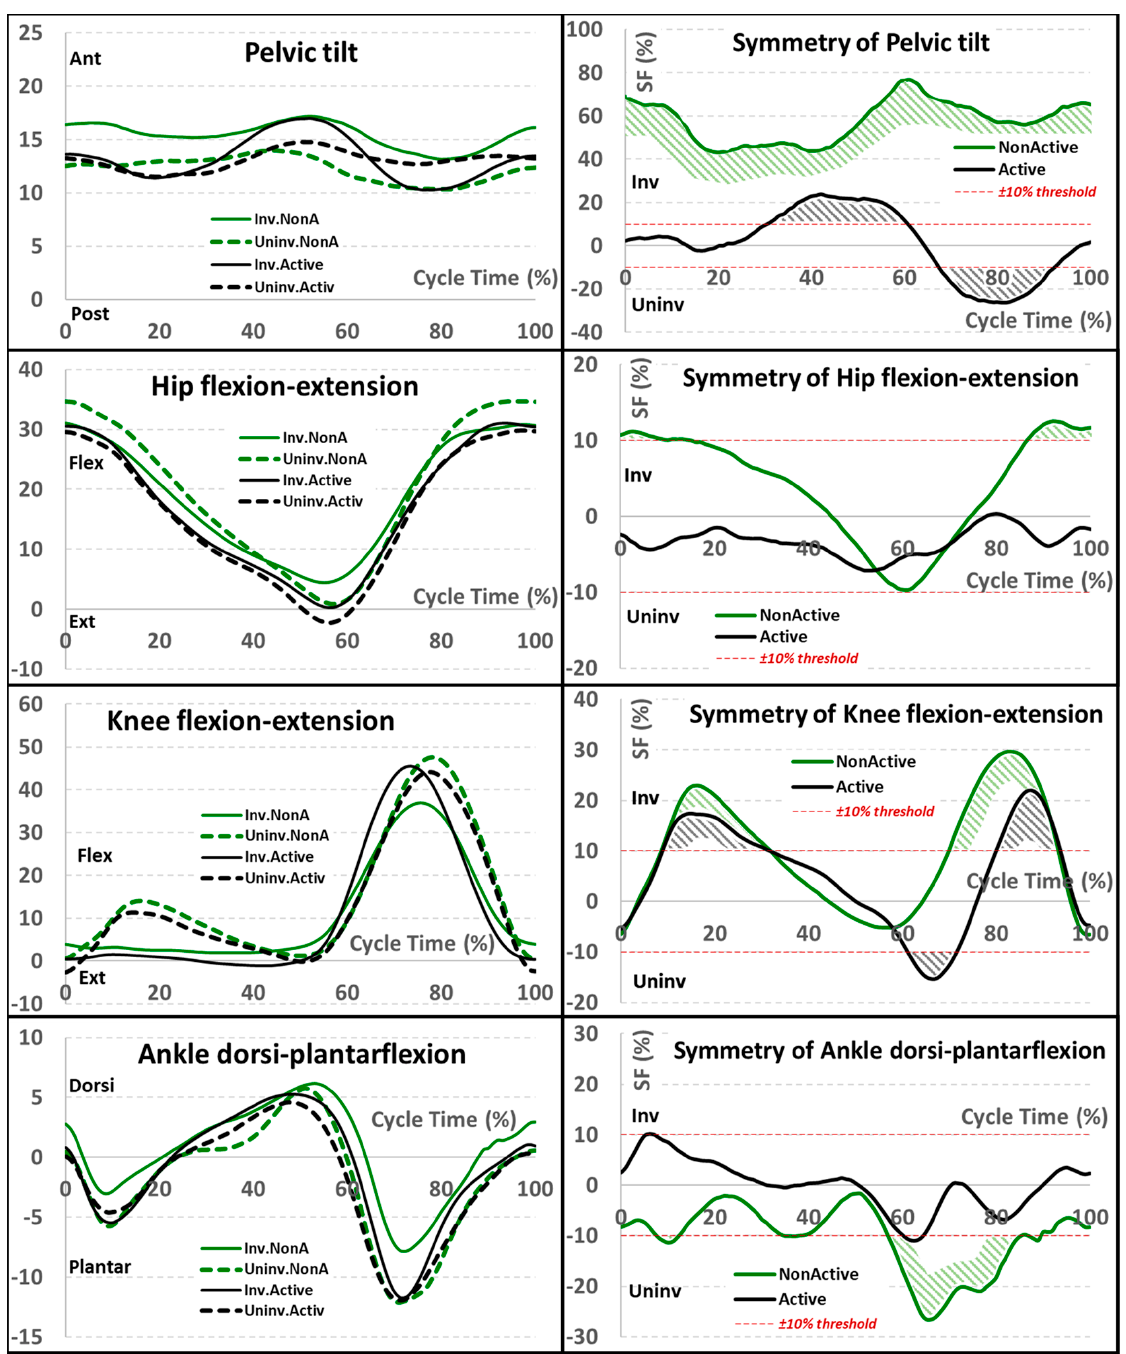
Figure 2. Sagittal plane kinematics for the pelvis, hip, knee and ankle joints (in degrees) for both involved/uninvolved limb and active/non-active groups ( on the left ); corresponding symmetry function (SF) for the active/non-active groups ( on the right ). The area exceeding the ±10% threshold was highlighted to discriminate between symmetrical and asymmetrical patterns. All angles are in degrees and the SF in percentage. Table 2. Sagittal, frontal and transversal plane kinematic results. Median, minimal, and maximal values and ±median absolute deviation (MAD).